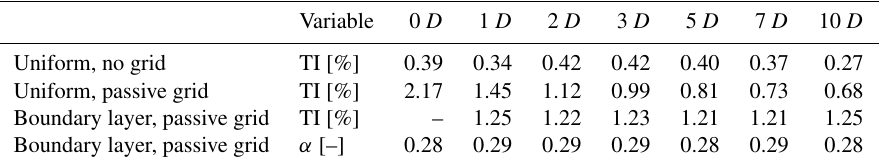
Table 1. Overview of the different inflow conditions used during the campaign. The turbulence intensity (TI) and the shear exponent ( α ) were obtained from the WindScanner data using the staring mode measurements at hub height (TI) and the averaged vertical planes ( α ).